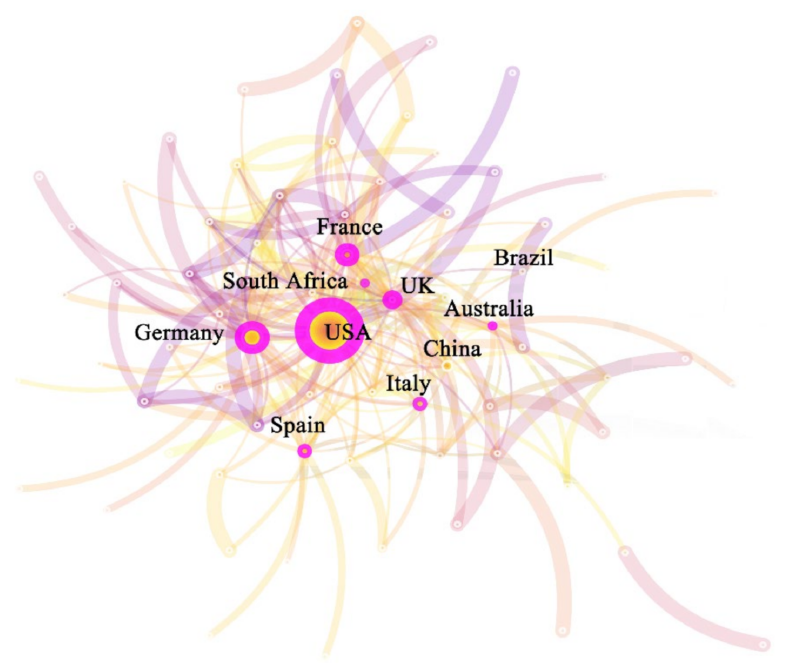
Figure 2. Network of national cooperation in the field of urban agriculture from 2001 to 2021.